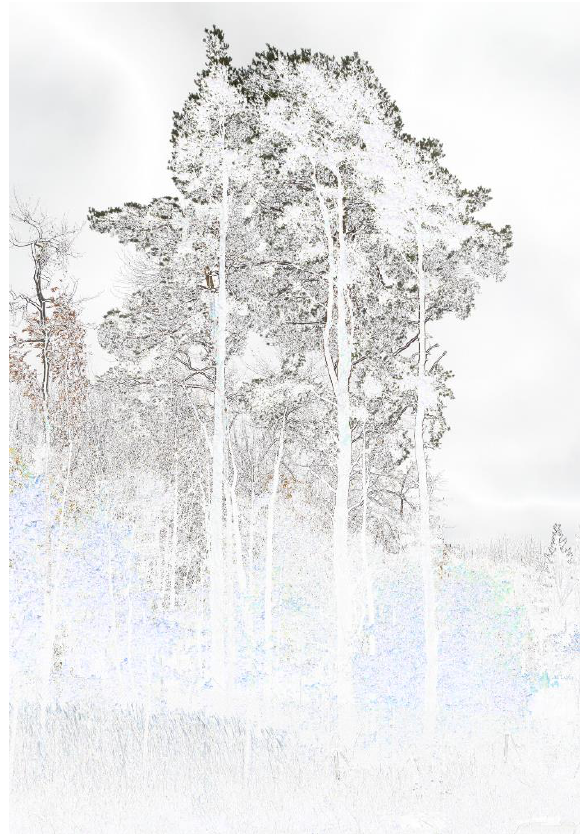
Figure 1. A photo from the site showing the pines and the measuring instrument used. The pine used in the analysis was the one on the right.